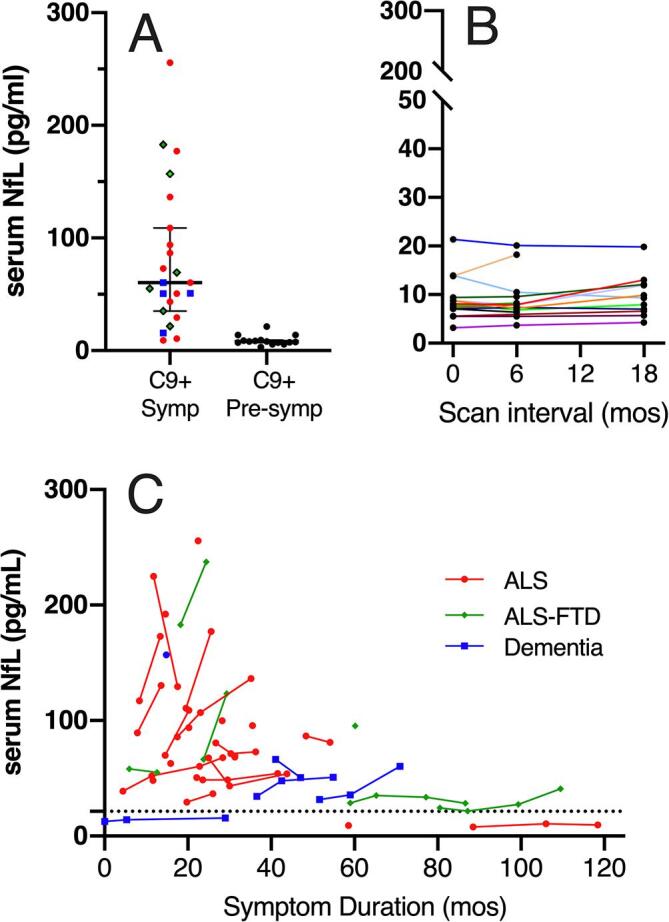
Levels of neurofilament light chain (NfL) in serum in A) Symptomatic C9orf72 carriers (C9+ Symp) and presymptomatic C9orf72 mutation carriers (C9+ Pre-symp) carriers at the time of scans. Symbols indicate clinical diagnoses red circles = ALS, green diamonds = ALS-FTD, blue squares = dementia. Median and interquartile range are shown. NfL levels shown for presymptomatic carriers in panel A were drawn at the time of the first scan. B) Longitudinal NfL levels in presymptomatic carriers. Each colored line represents a different presymptomatic carrier. C) Levels of NfL in symptomatic C9+ carriers in relation to symptom duration, showing high levels early in symptom onset. Each line indicates an individual C9+ patient (red circles = ALS, green diamonds = ALS-FTD, blue squares = FTD). The dotted line represents the highest serum NfL measure obtained in the presymptomatic C9+ carriers. (For interpretation of the references to colour in this figure legend, the reader is referred to the web version of this article.)